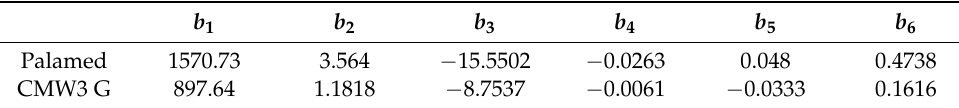
Table 5. Fitting parameters of the compression modulus models.